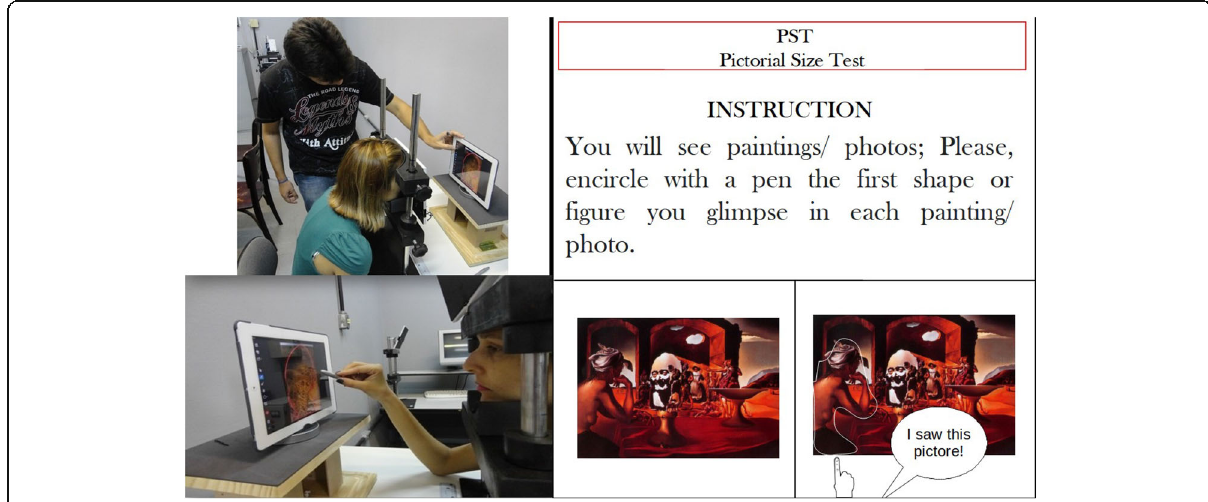
Fig. 2 Experimental apparatus and instructions. The actual setting depended on the site where data was being